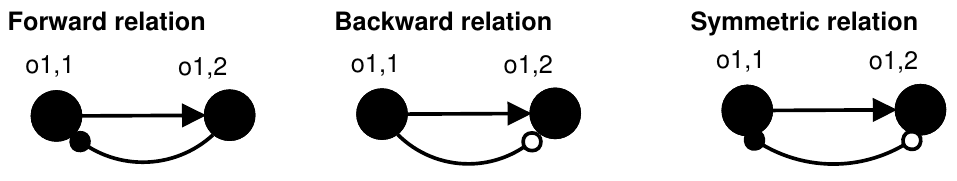
Figure 2. Edges reflecting the relationship between operations.